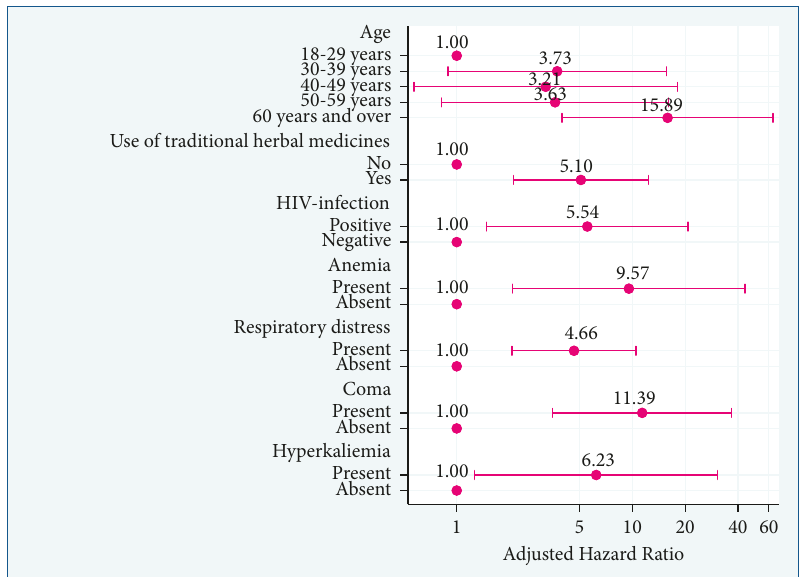
Figure 1: Cox multivariate regression analysis of independent predictors of mortality in AKI stage 3 patients up to 30 days admitted to the hemodialysis